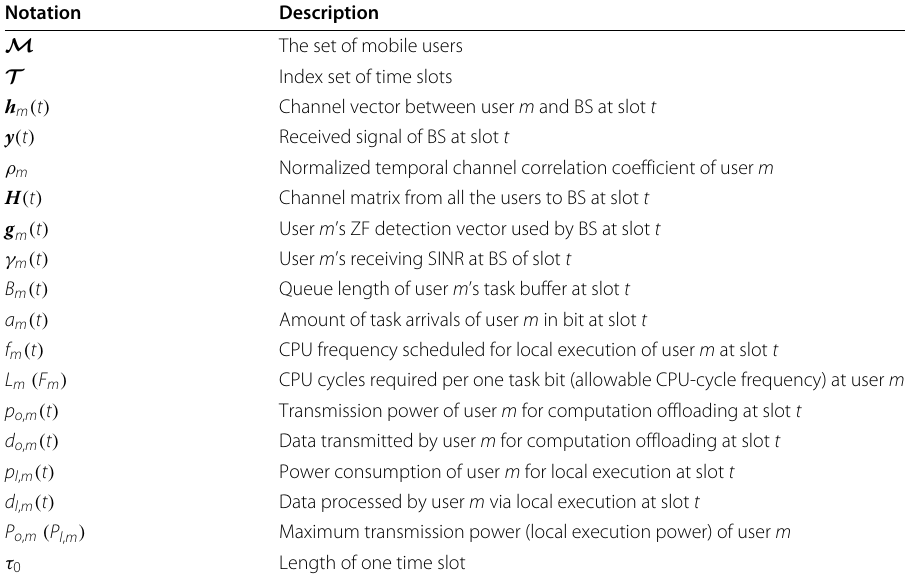
Table 1 Summary of